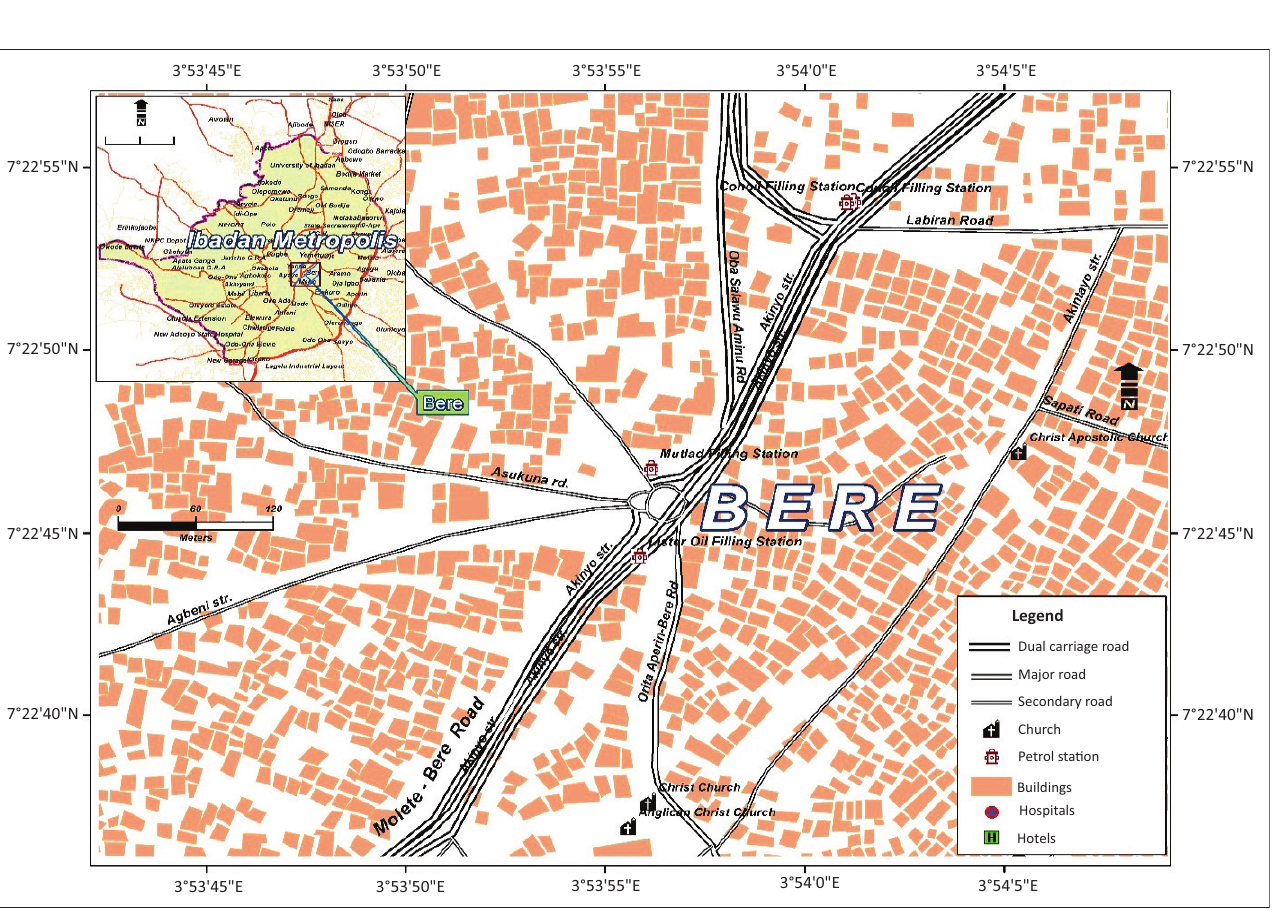
FIGURE 2: Map of Bere community at the core of the city